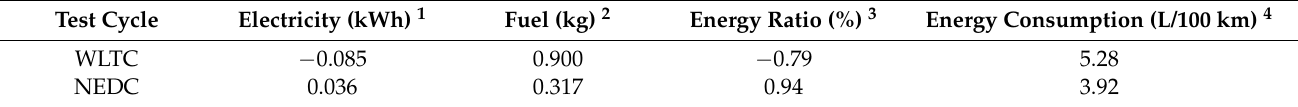
Table 2. Energy consumption result.